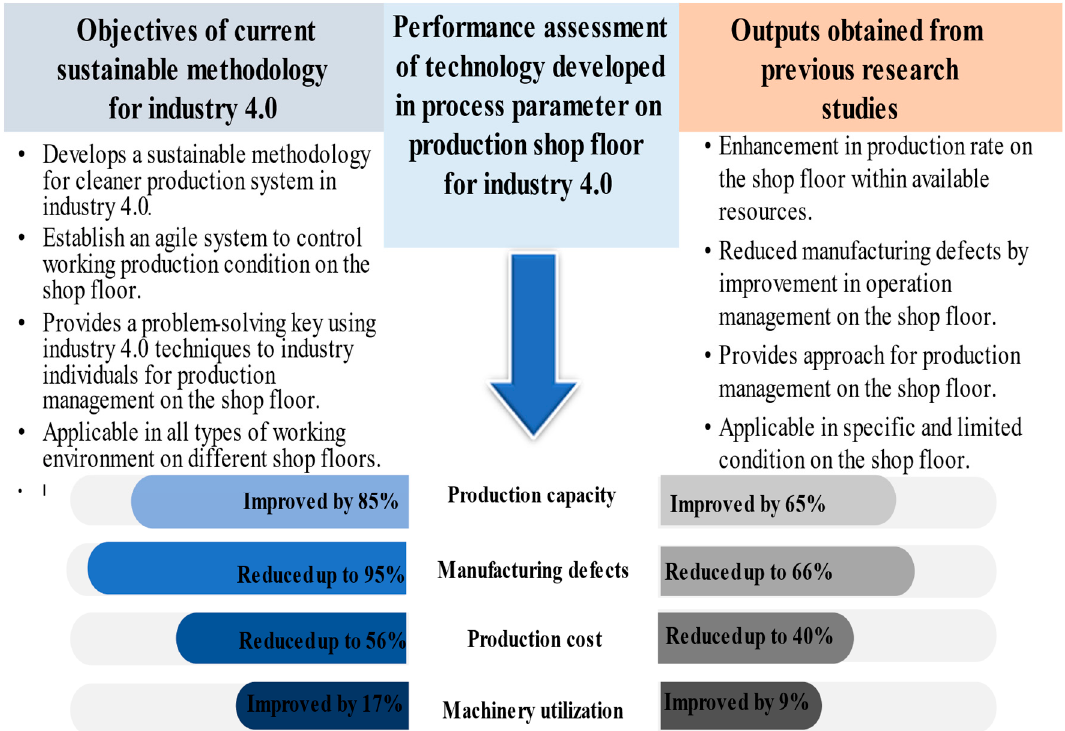
Figure 13. Comparison of the outcomes between the current sustainable methodology and previous research studies.